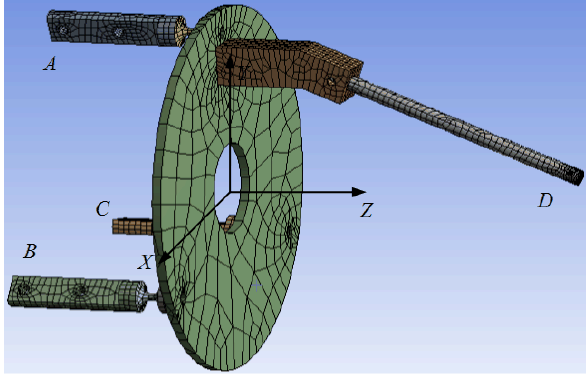
Figure 6. The meshed finger model.